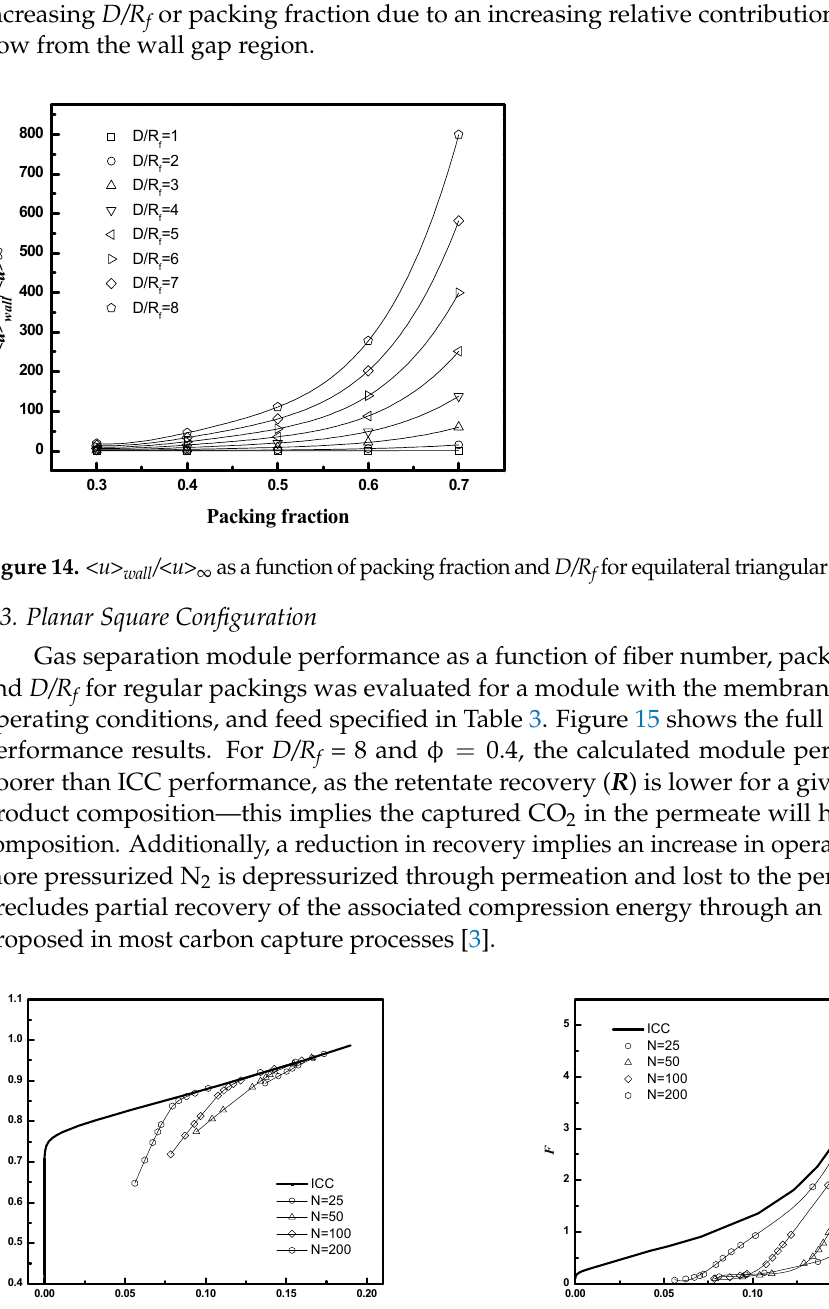
Figure 13. <u>/<u> ∞ as a function of fiber number for equilateral triangular configuration with different D/R f . ( ɸ = 0 .4).